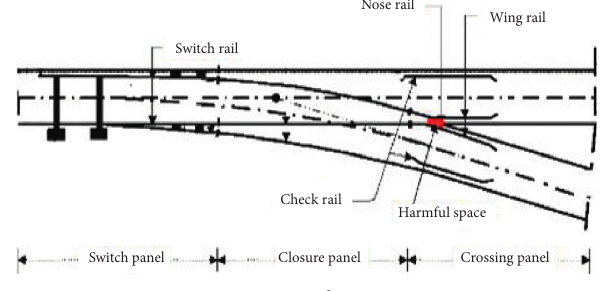
Figure 1: Single